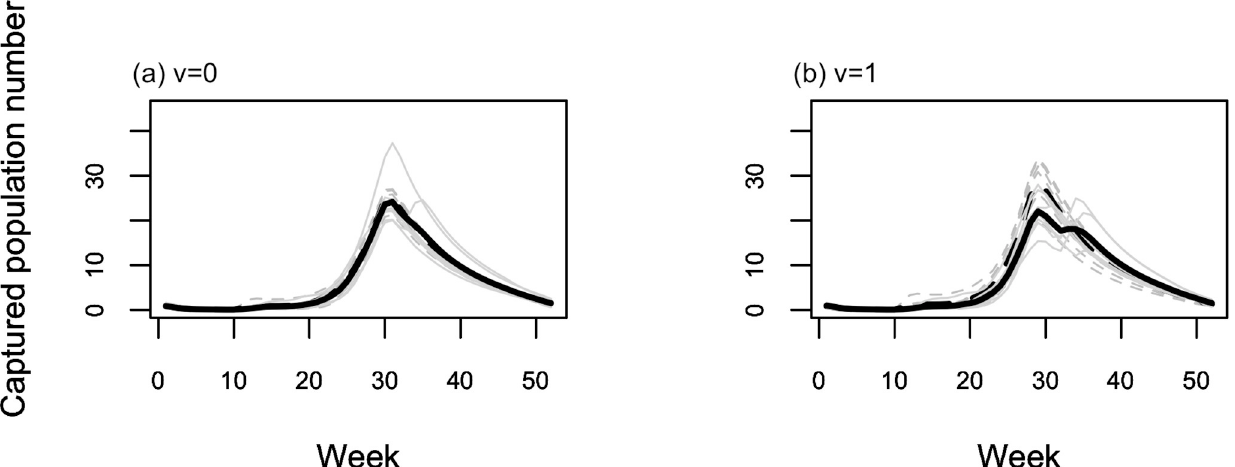
Fig 3. Population dynamics (2003–2009) with two different climate data using model having (a) v = 0 and (b) v = 1. Solid line represents the prediction using the observed climate data and dashed line represents those with global climate model (GCM) historical data. Light and strong colors indicate the result of each year and its average, respectively.